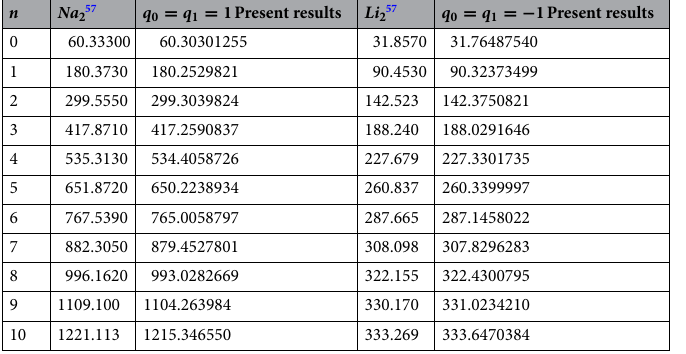
+ g state of cesium dimer. (cid:31)